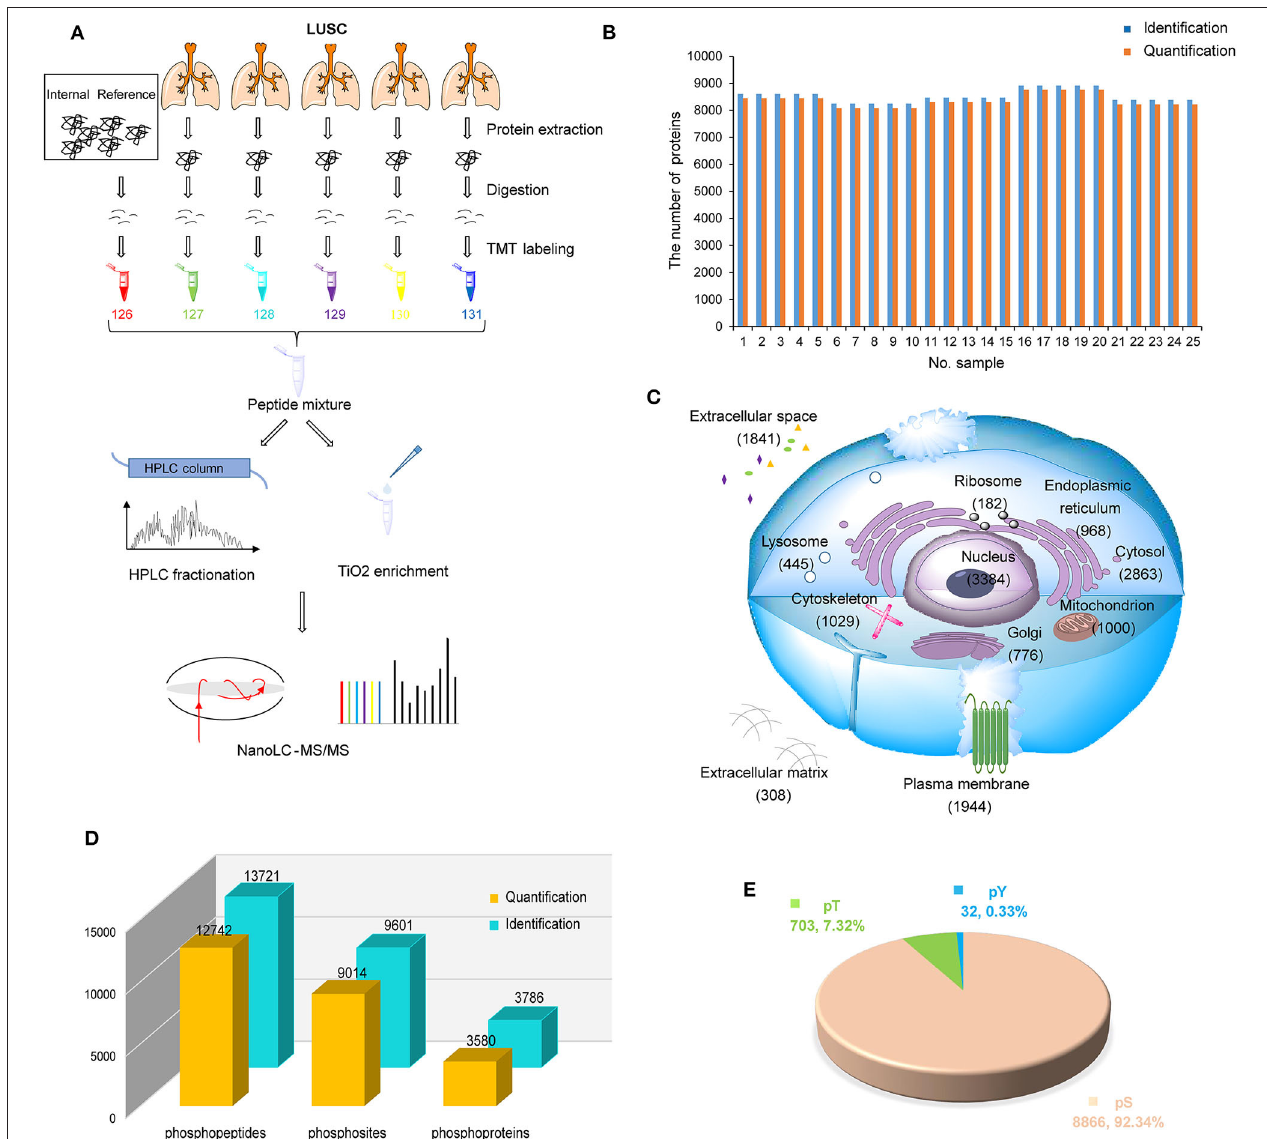
FIGURE 1 | Proteomic and phosphoproteomic analysis of lung squamous cell carcinoma (LUSC). (A) Workflow of proteomic and phosphoproteomic profiling of LUSC. (B) The number of identified and quantified proteins in proteomic profiling. (C) Subcellular distribution of LUSC gene products annotated with Gene Ontology. (D) The number of identified and quantified phosphopeptides/sites/proteins in phosphoproteomic profiling. (E) Phosphosite distribution on S/T/Y phosphorylation